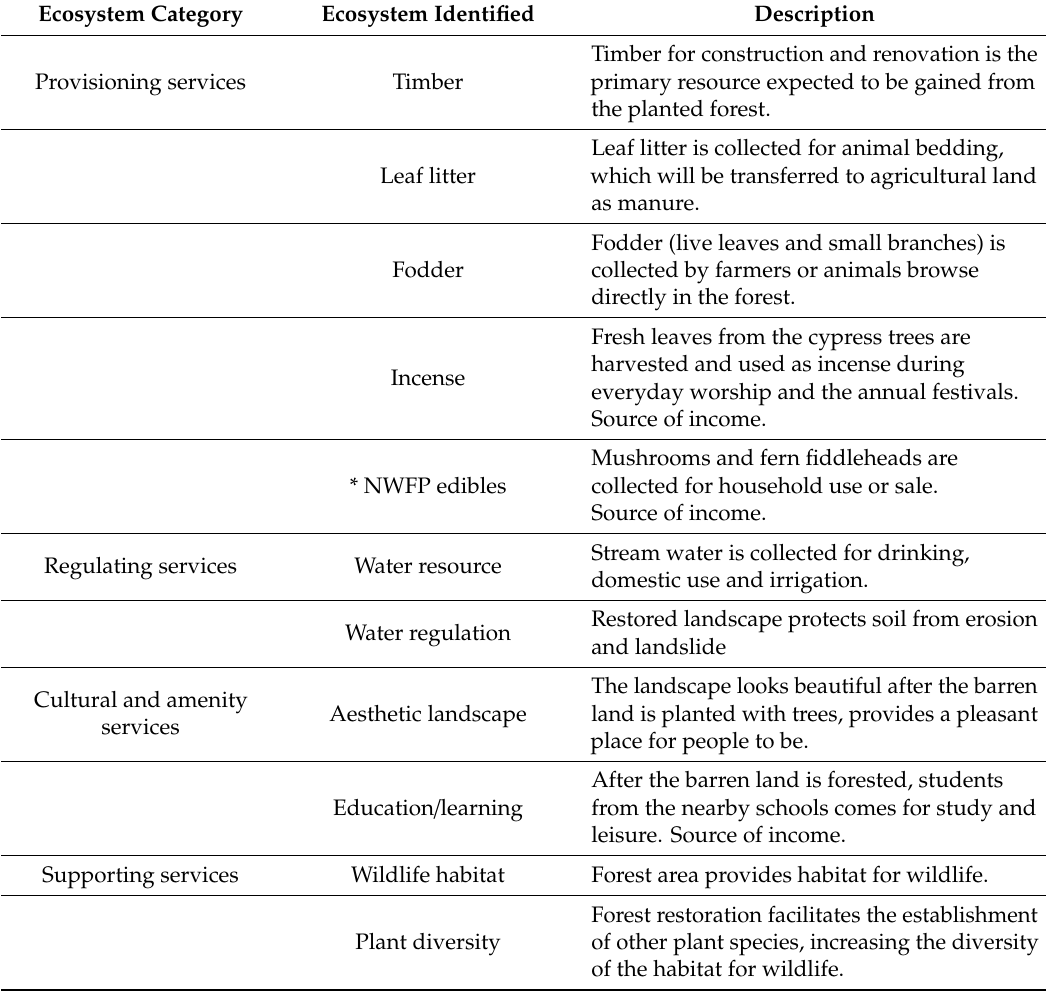
Description of ecosystem services from the planted forests in Punakha and Trashigang